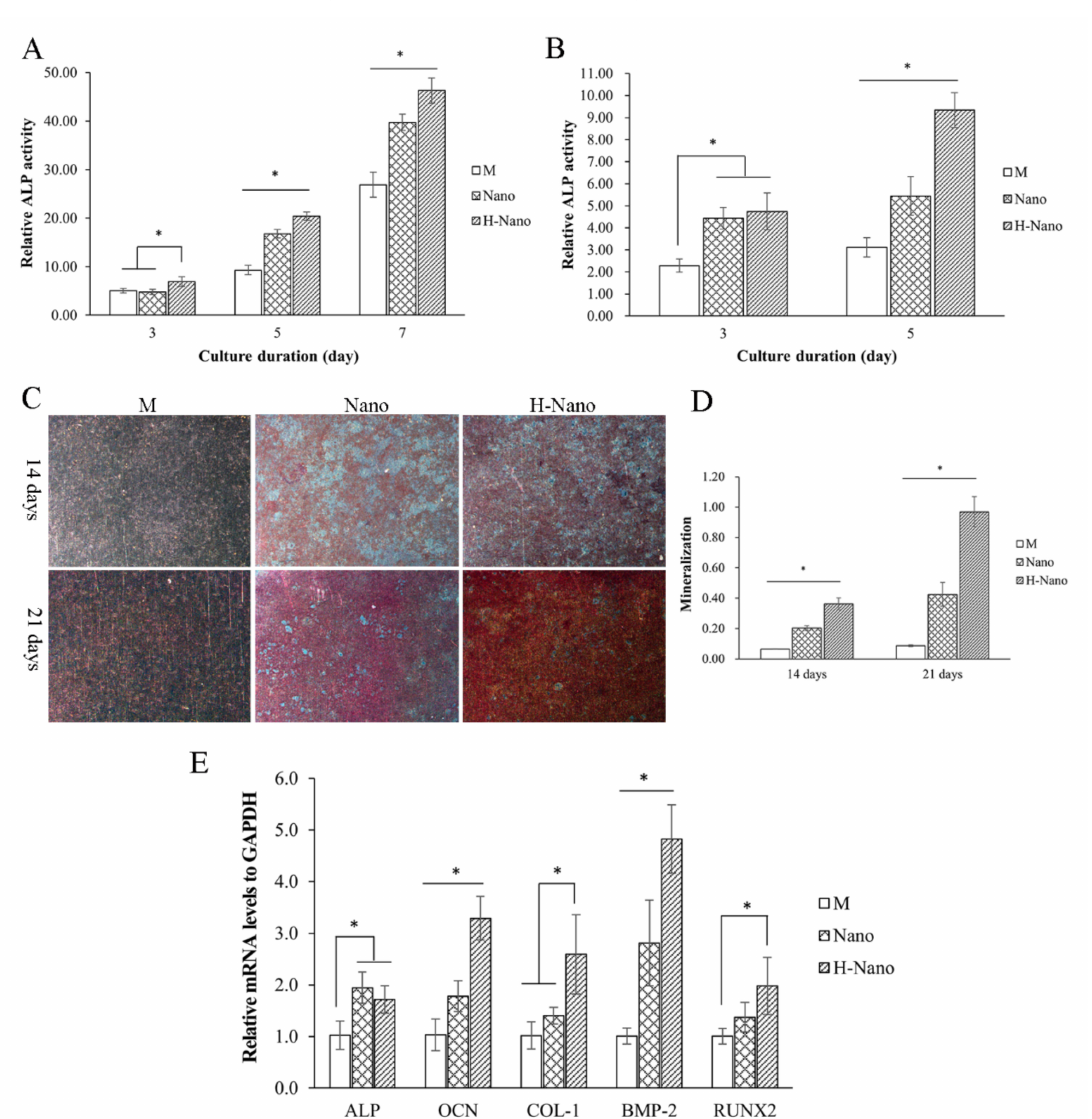
Figure 3. ( A ) Relative alkaline phosphatase (ALP) activity of BMSCs on the M, Nano, and H-Nano surfaces cultured in the osteogenic medium for 3, 5, and 7 days. ( B ) Relative ALP activity of